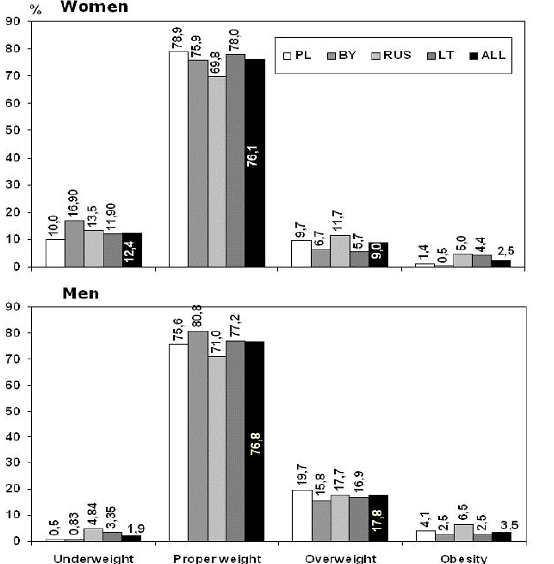
Figure 1. The distribution of BMI classes by country in women and men